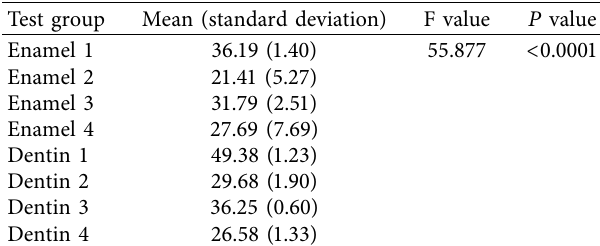
Table 2: Comparison of mean shear bond strengths of eight enamel and dentin